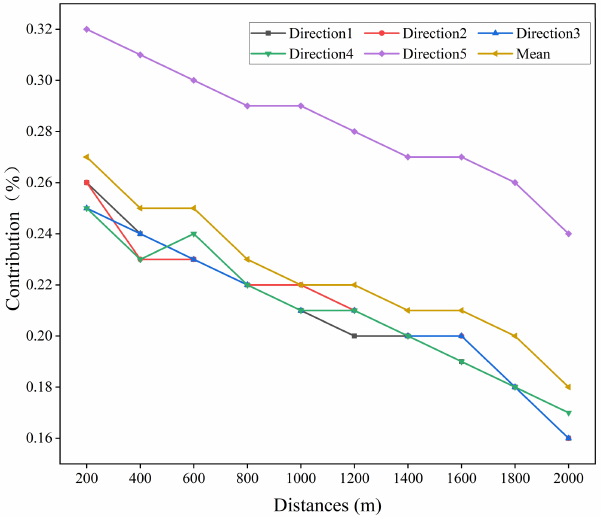
Figure 13. The contribution of the mining factor at different distances from the boundary of Shengli